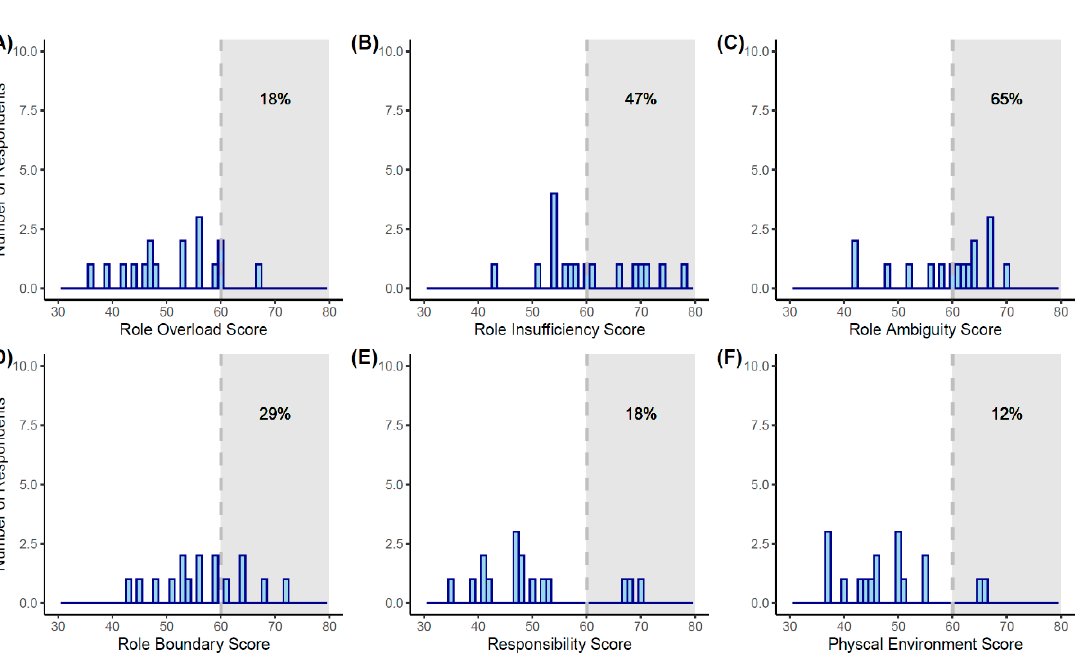
Figure 1. Occupational stress of each subdomain among the study population. Histograms depicting score frequency by the subdomains of ( A ) Role Overload, ( B ) Role Insufficiency, ( C ) Role Ambiguity, ( D ) Role Boundary, ( E ) Responsibility, and ( F ) Physical Environment. The shaded areas in which the T-score is larger than 60 indicate the presence of occupational stress in each subdomain.